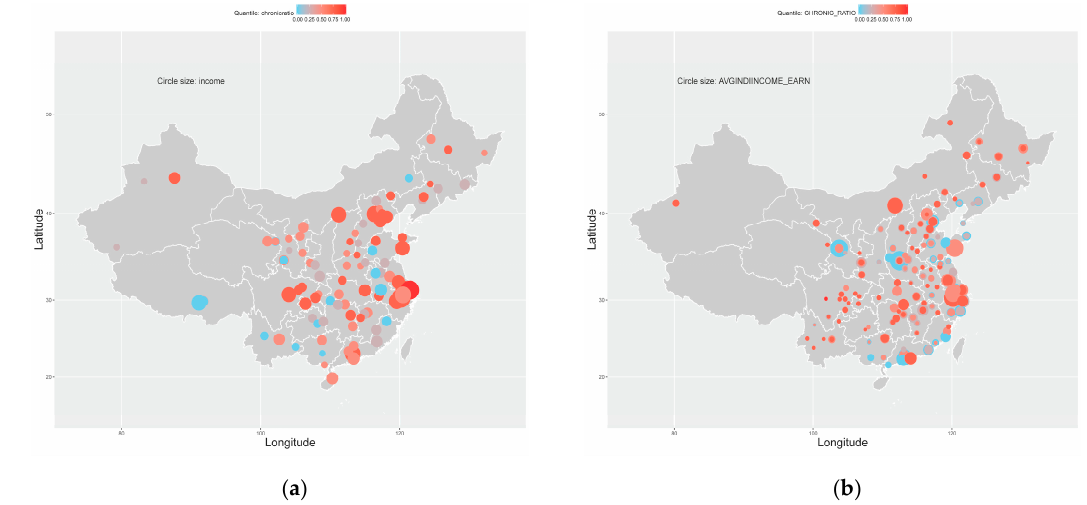
Table 3. Gini coefficients of health outcomes.